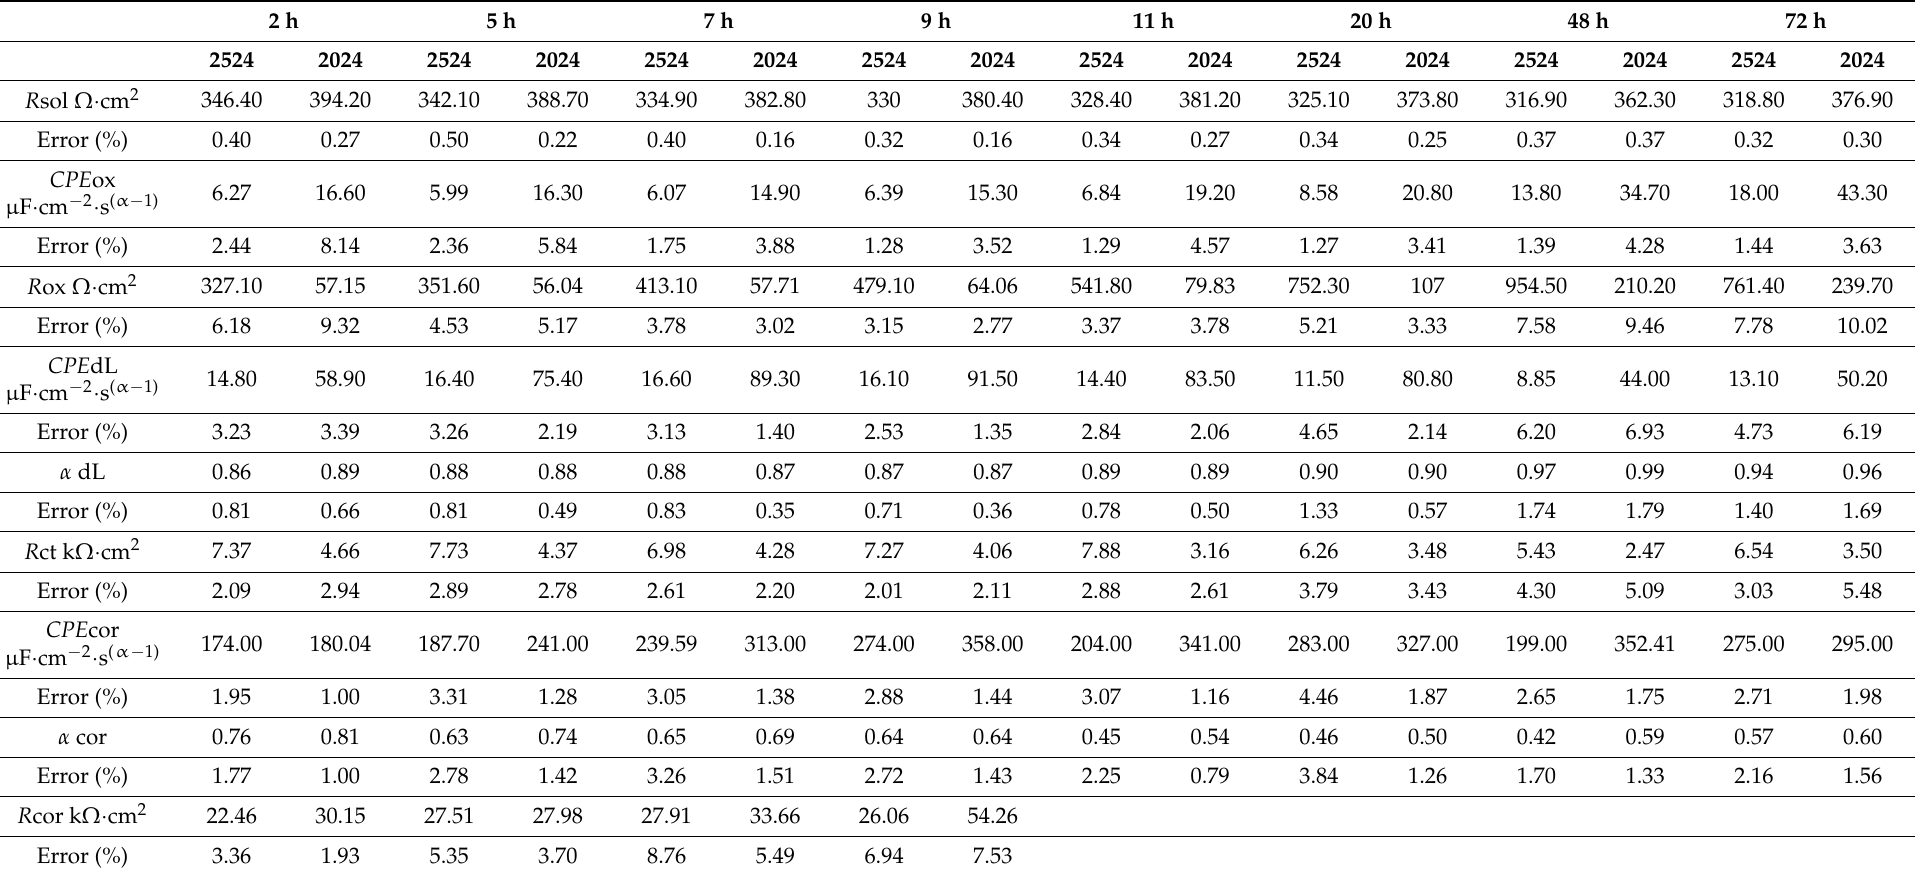
Table 4. Parameters obtained from the equivalent electrical circuit fitted to the AA2024-T3 and AA2524-T3 EIS